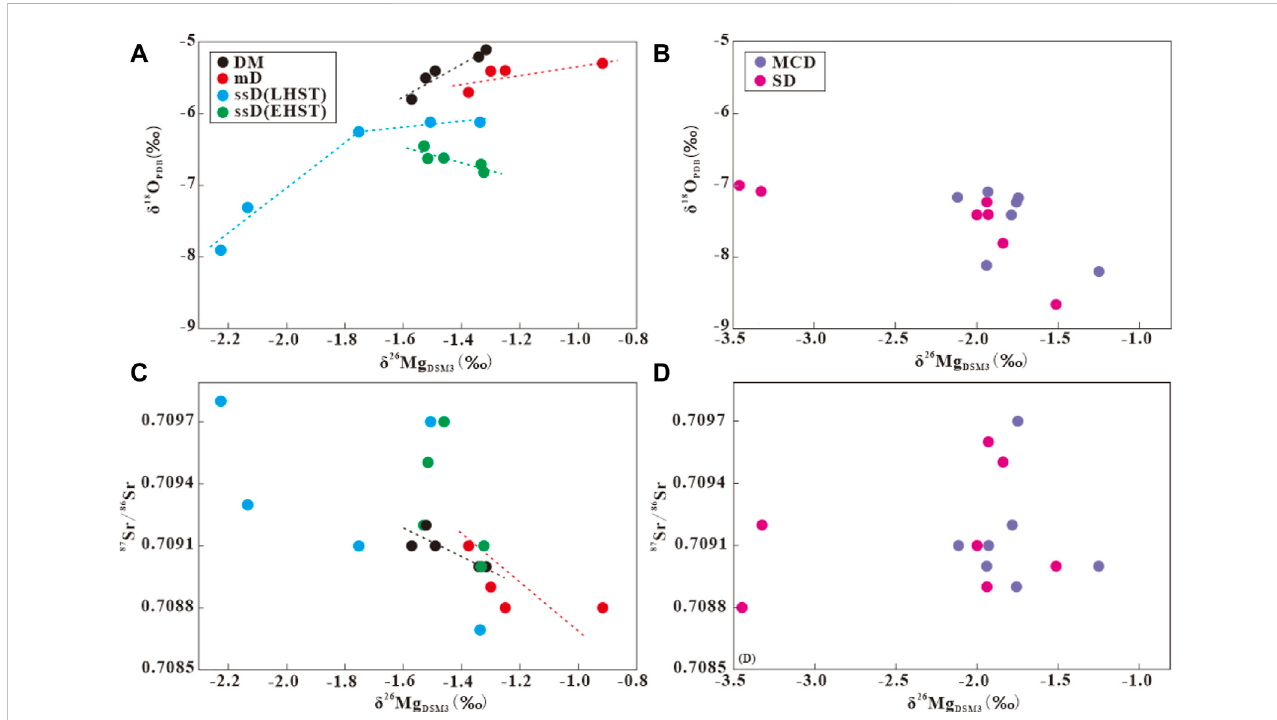
FIGURE 9 Isotopic crossplots oftheupperchangpingformation. (A) Oxygenandmagnesium isotopiccrossplotofDM,mD,andssD; (B) Strontium andmagnesium crossplot of DM, mD, and ssD; (C) Oxygen and magnesium isotopic crossplot of MCD and SD; (D) Strontium and magnesium crossplot of MCD and